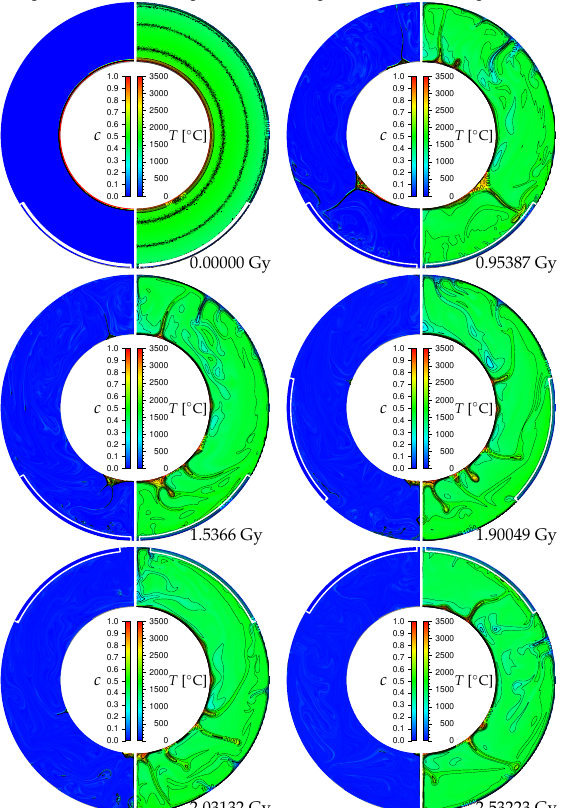
Figure 11. Same as Figure 4, but for Case 6.